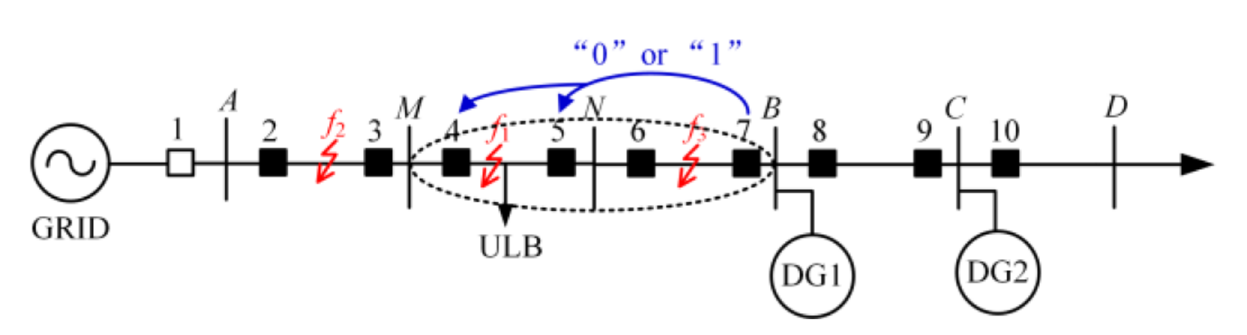
Figure 12. Simple distribution network with